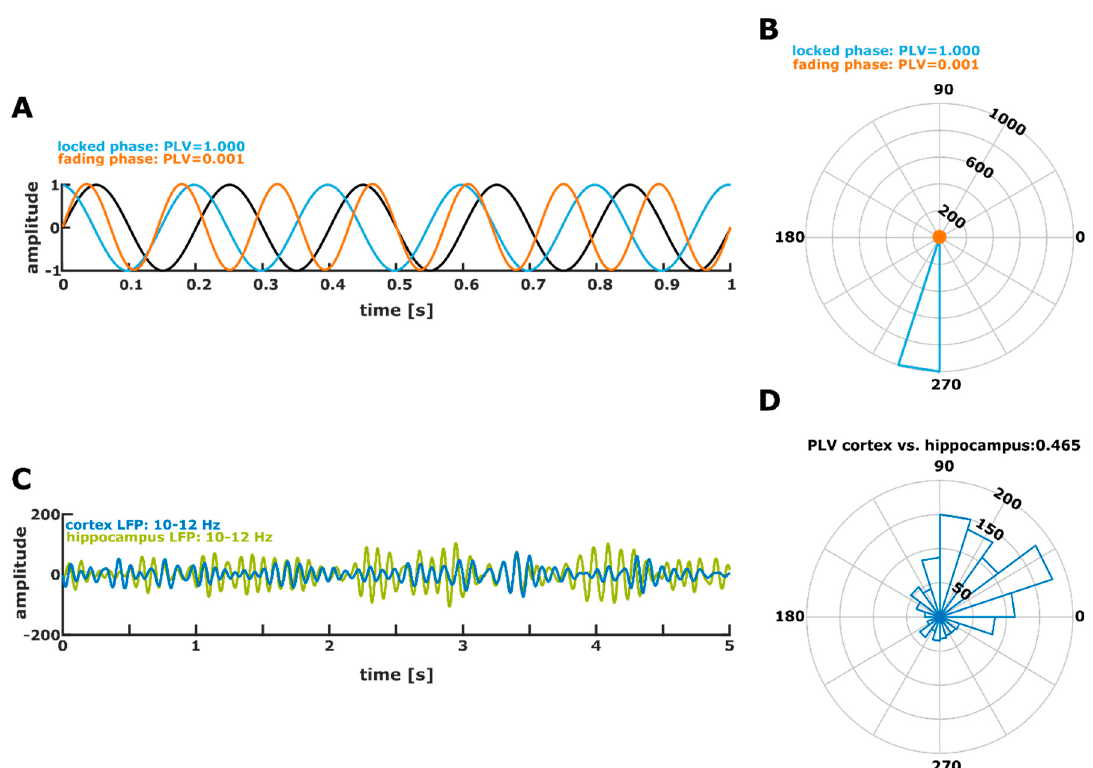
Figure A2. Example for the calculation of PLV for two signals of “locked phase”, i.e., a perfect PLV = one and two signals with “fading phase”, i.e., no phase locking leading to a PLV = 0.001 as well as for real prefrontal cortical and hippocampal LFP. ( A ) “Locked phase” represents the association between the original (black) signal and a signal of same frequency and amplitude shifted by 270 degrees. “Fading phase” represents the association between the original (black) signal and a signal of higher frequency (yellow) leading to a constantly changing phase relationship. ( B ) The polar representation of the “locked phase” shows that at all times, the phase difference resides in the 270-degree corridor. For the “fading phase”, the phase difference is equally distributed over all angles. ( C ) LFP recordings simultaneously recorded from the prefrontal cortex and the hippocampus that were filtered to the 10–12 Hz range. ( D ) The polar representation of the phase differences shows an accumulation of observations in the upper right quadrant. The resulting PLV is 0.465. PLV: phase locking value; LFP: local field potential.